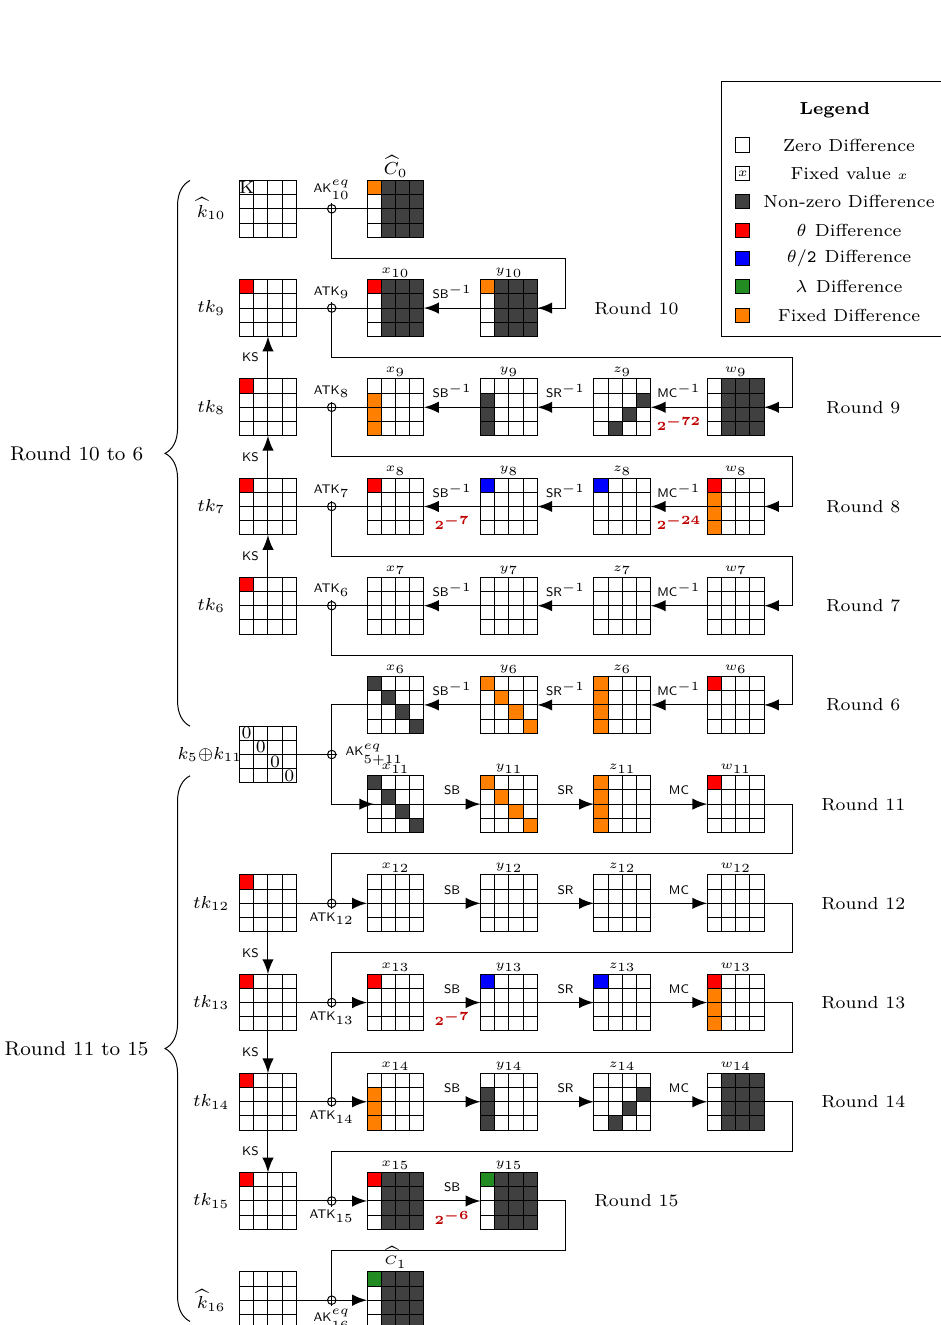
Figure 3: Differential characteristic for very weak